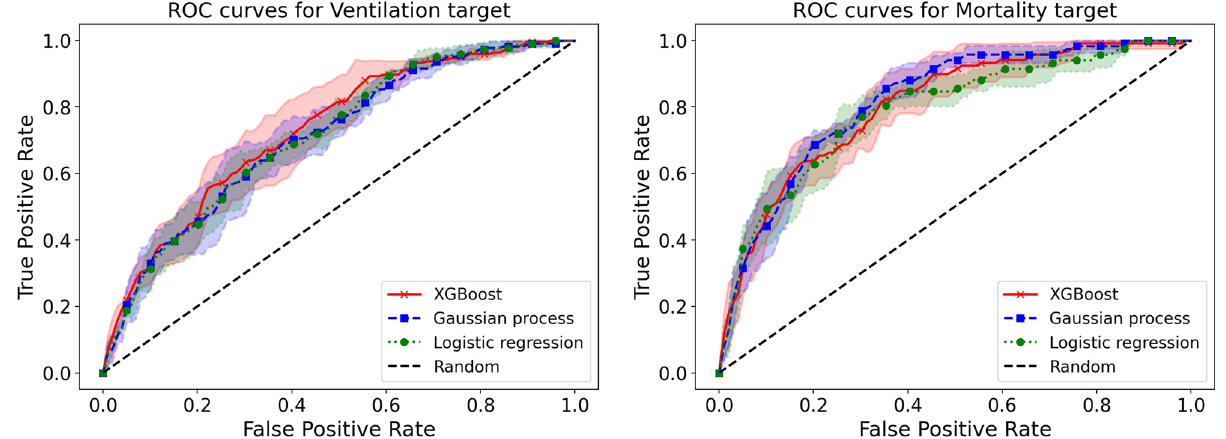
Figure 3. Receiver operating characteristic (ROC) curves on the ventilation and mortality tasks. The lines are the mean ROC curves over 5 different train/test splits and the shaded areas represent ± 1 standard deviations from the means. The performance of the three models is comparable, with XGBoost having the best performance in the ventilation task and the Gaussian process classifier having slightly better performance in the mortality task. The area under the curve (AUC) scores for all the models are reported in Table 4.